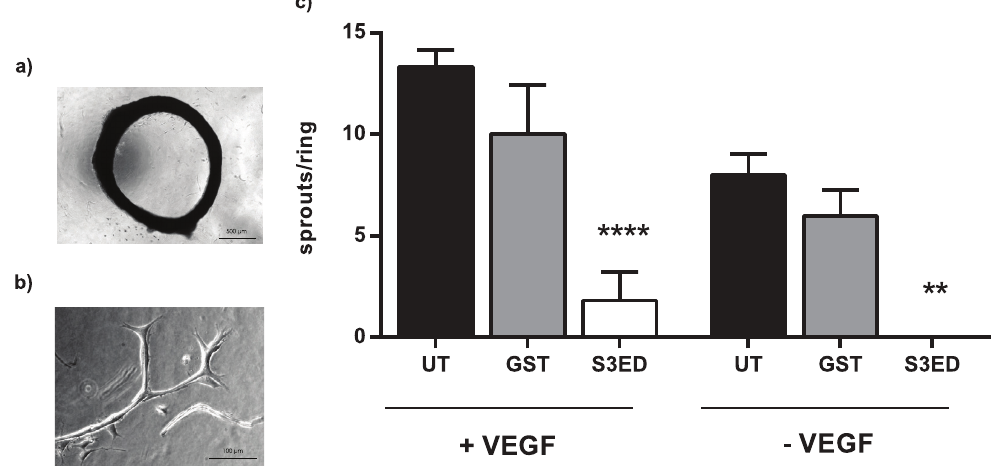
Figure 2. S3ED inhibits sprout formation in the rat aortic ring assay. ( a ) Low magnification (bar=500 µm) of a rat aortic ring and ( b ) high magnification (bar=100 µm) image of an angiogenic sprout grown under control conditions. ( c ) S3ED inhibits angiogenic sprout formation from rat aortic rings. Rat aortic rings were seeded in Collagen I gels with 0.5 µM of either S3ED or GST in the presence or absence of VEGF. Data is the mean taken from rings from 3 different animals and error bars represent the SEM. One-way ANOVA with Bonferroni multiple comparisons was used to compare S3ED to relative UT